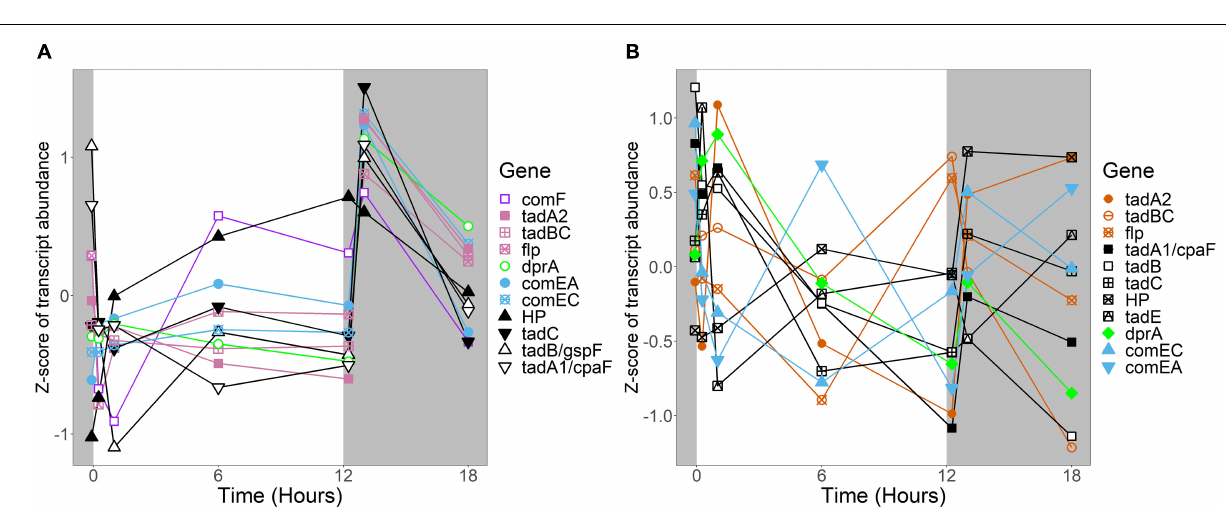
FIGURE 8 | Expression of putative competence genes. Putative competence genes were identified by blasting the amino acid sequences of known components of the Com operon and tad/flp pilus from Micrococcus luteus against the genomes of R. lacicola and A. photophilum strain MWH-Mo1. In both strains, components of the putative tad/flp pilus are organized into two operons, and comEC and comEA form a separate putative operon. Expression is plotted as z-score of each transcript. (A) Putative competence genes in R. lacicola . (B) Putative competence genes in A. photophilum strain